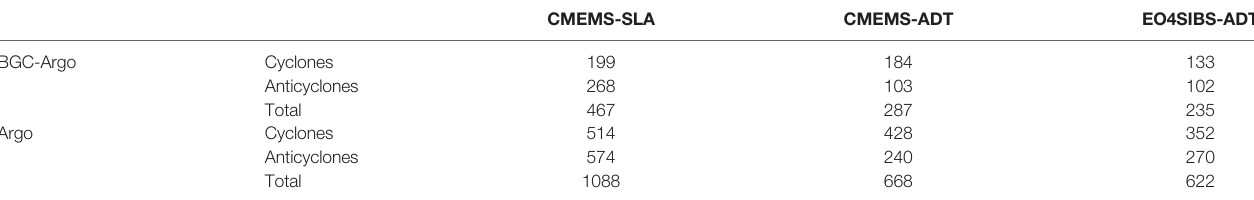
A match-up means an Argo pro fi les is located within the effective contour of an identi fi ed eddy.